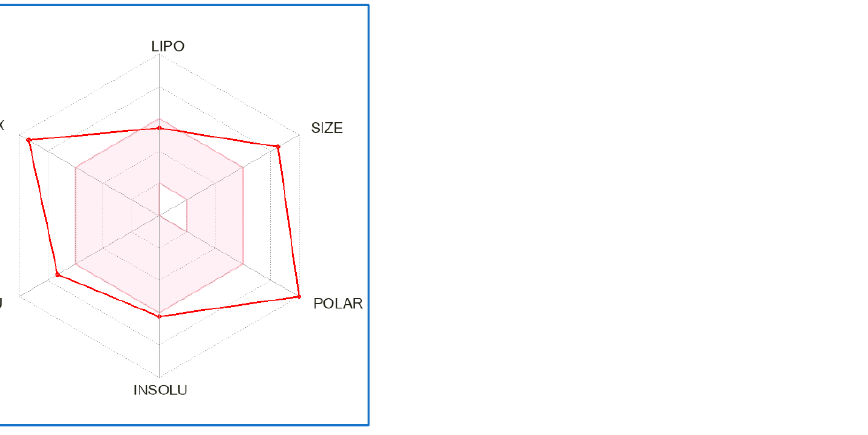
Figure 1. Bioavailability radar chart of SalB. The bioavailability radar gives a first glance on the drug-likeness of the compound, considering a total of six physicochemical properties: lipophilicity, size, polarity, solubility, flexibility and saturation. The pink zone represents the physicochemical space for oral bioavailability, and the red line represents the specific oral bioavailability properties associated with the analyzed compound.